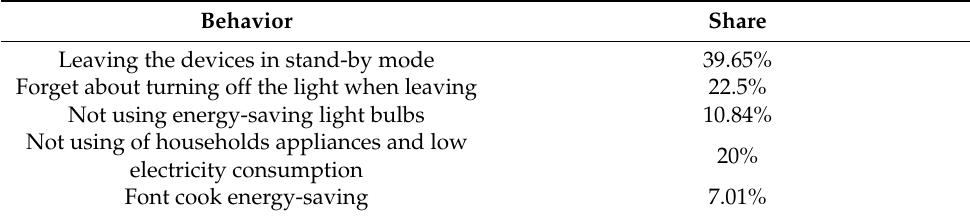
Table 9. Behavior of respondents that increases energy